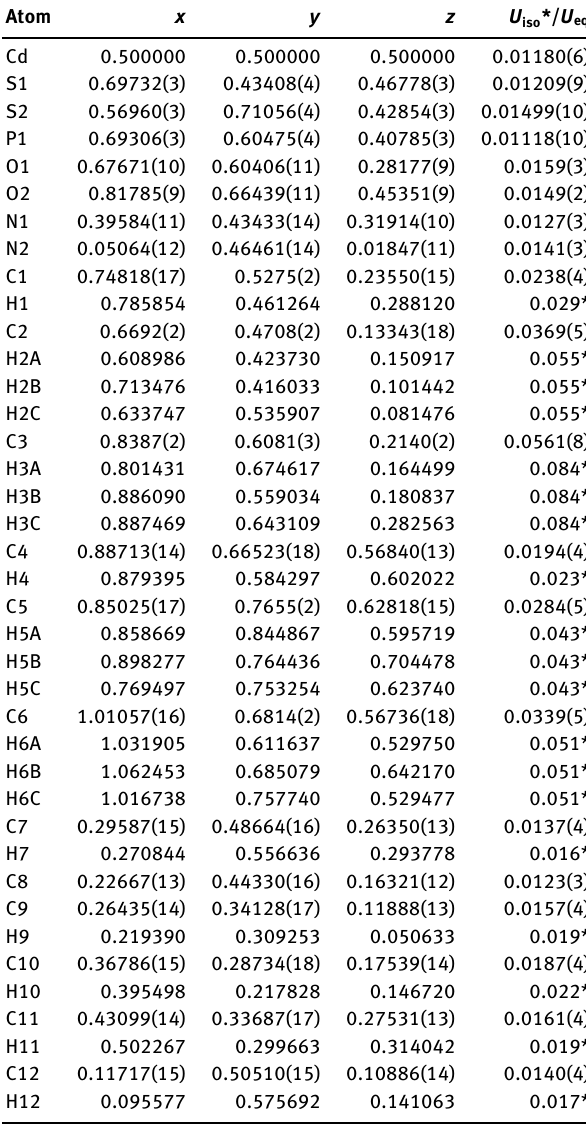
Table 2: Fractional atomic coordinates and isotropic or equivalent isotropic displacement parameters (Å 2